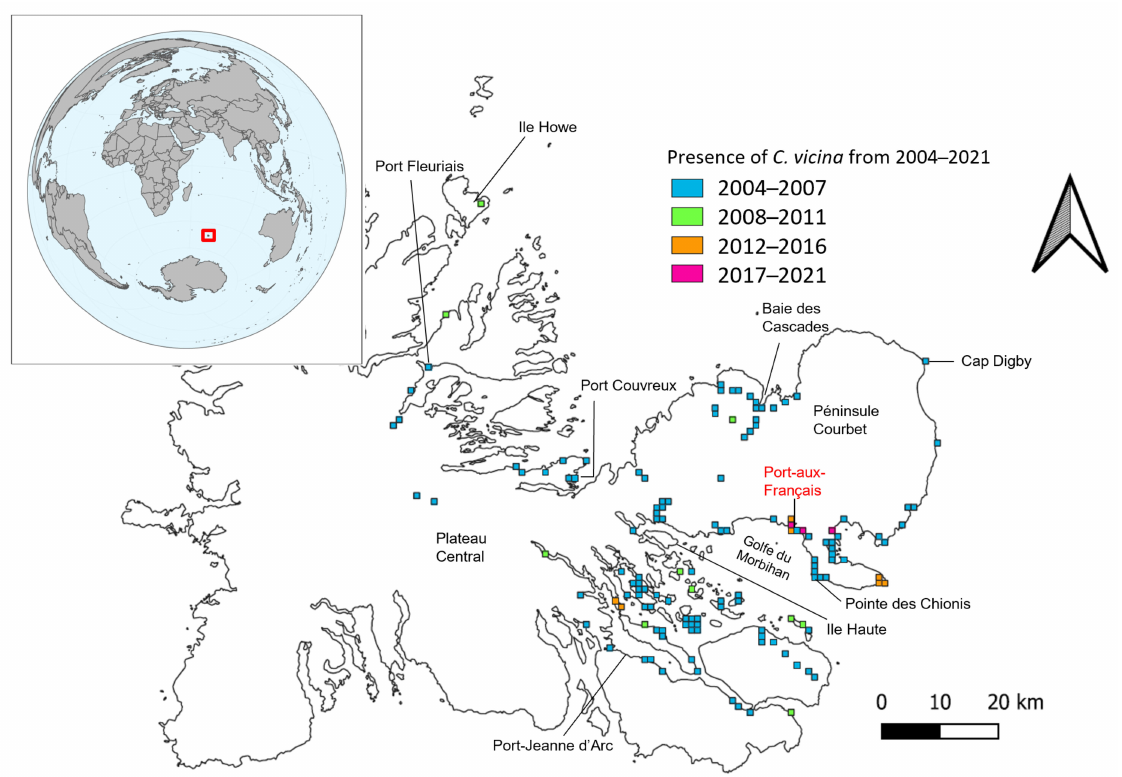
Figure 3. Changes in the distribution of Calliphora vicina on the Kerguelen Islands in the time range 2004–2021. The occurrence points report the period of first observations of the presence of C. vicina . Note that in most localities, the species was observed repeatedly in the periods following its initial observation. Distribution map generated in QGIS version 3.22.5 with observations plotted on a one-kilometre